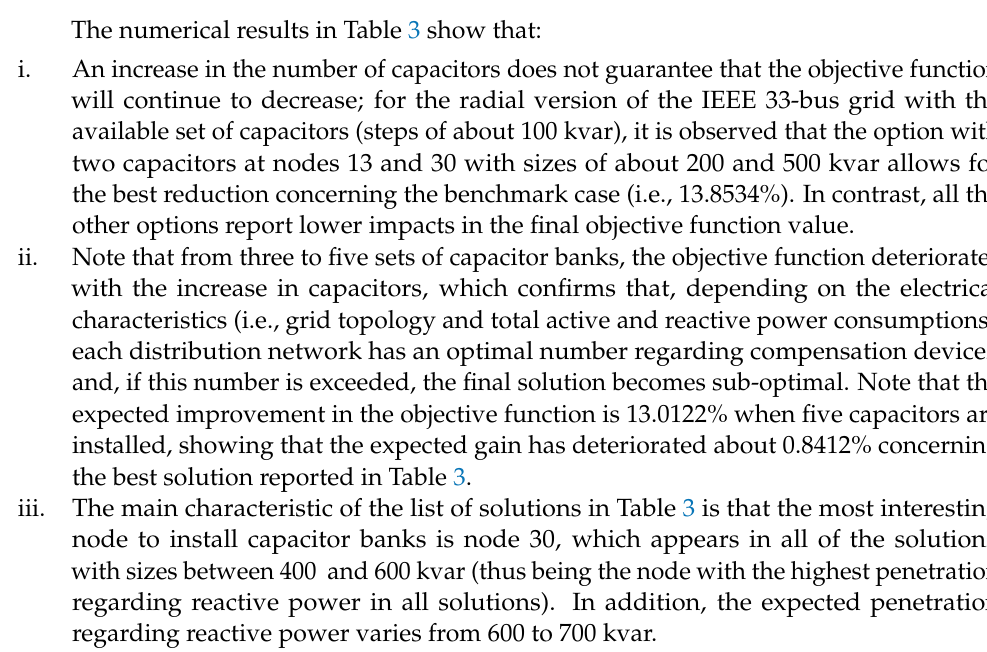
The numerical results in Table 3 show